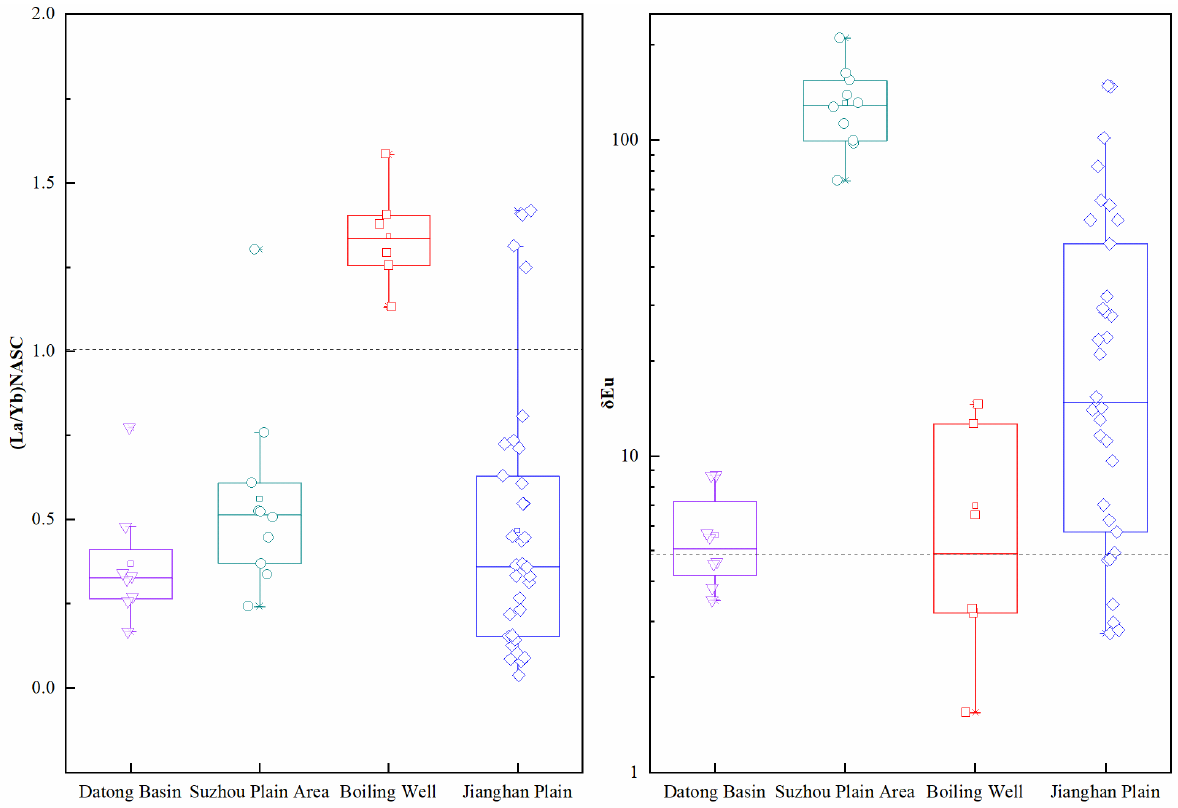
Figure 5. Comparison of groundwater (La/Yb) NASC and δ Eu between Boiling-Wells and other plain areas. plain